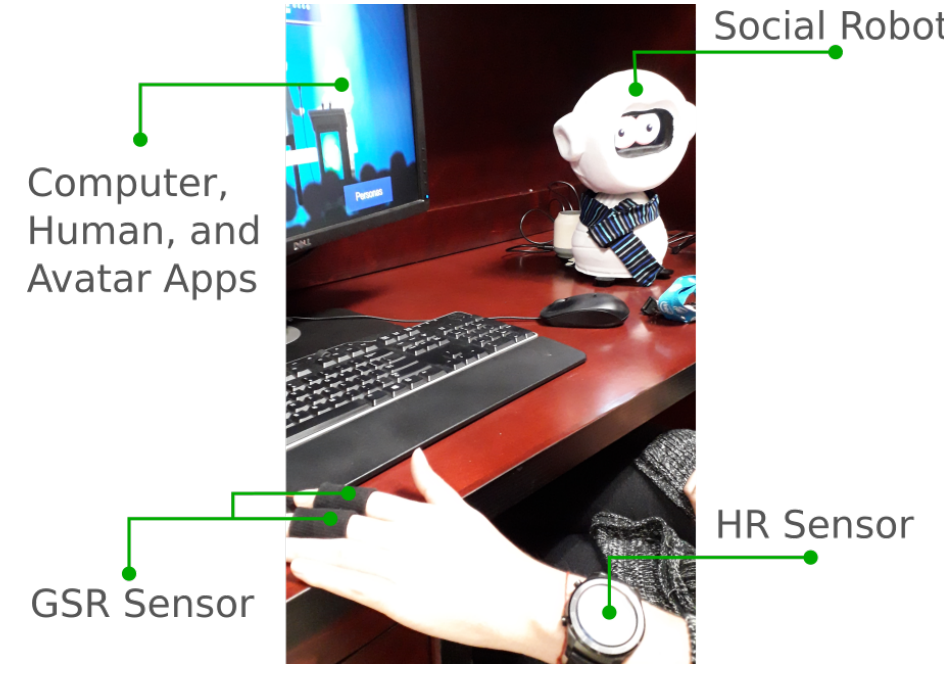
Figure 3. Experimental